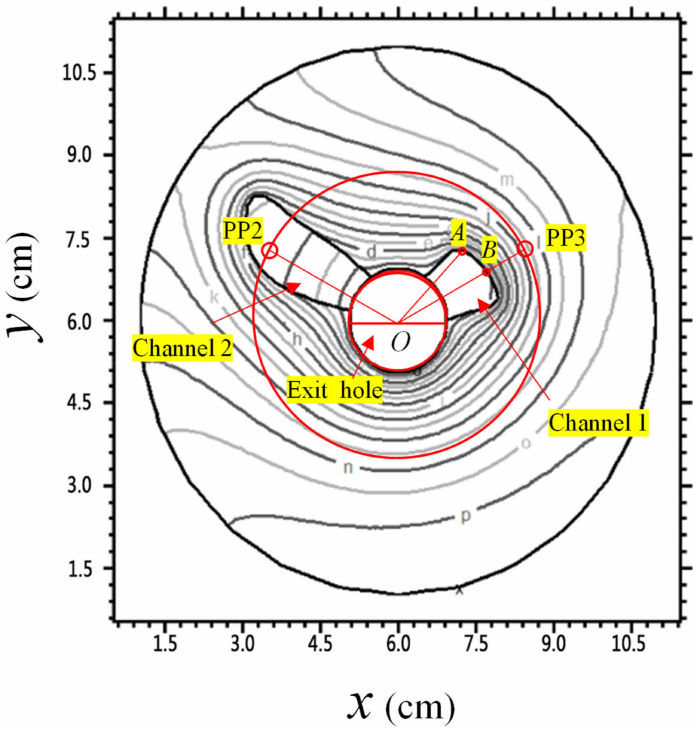
Figure 10. Schematic illustration of simplified application of the laboratory model ( ∆ H = 7.6 cm).